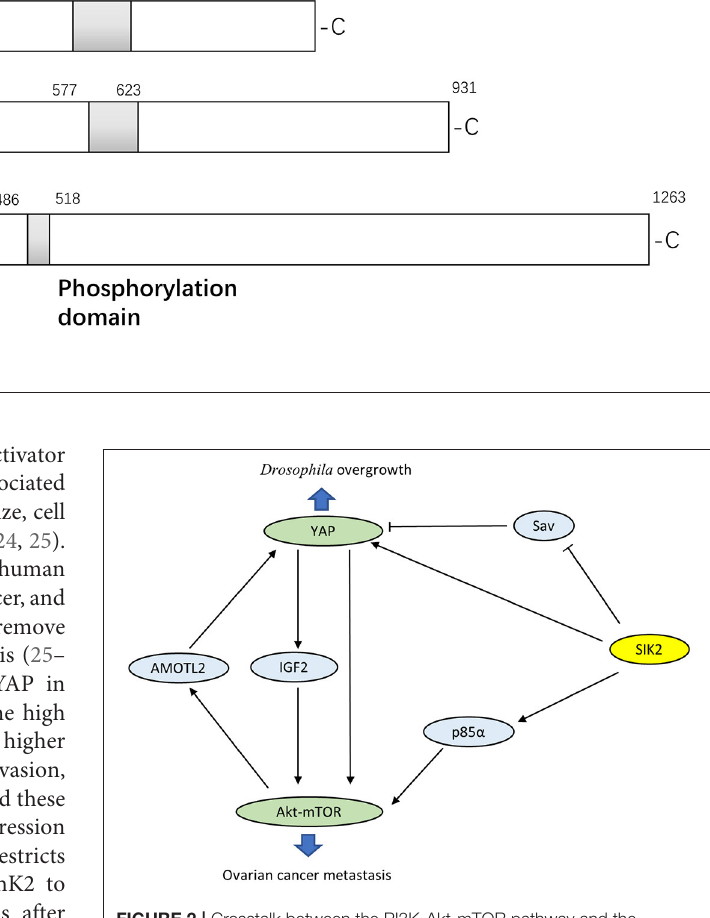
SIK2 in these intersecting pathways is not well-understood, and future studies are still desperately needed to elucidate the related detailed